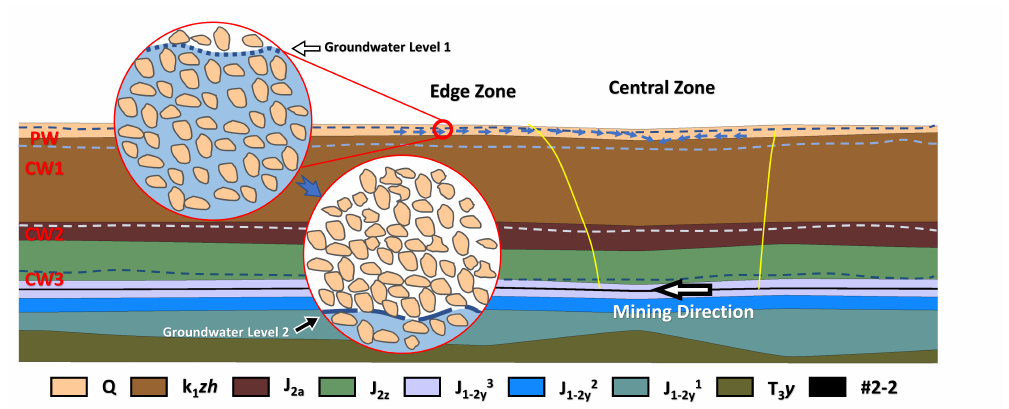
Figure 17. The pore filling effect of aeolian sand layer in the initial